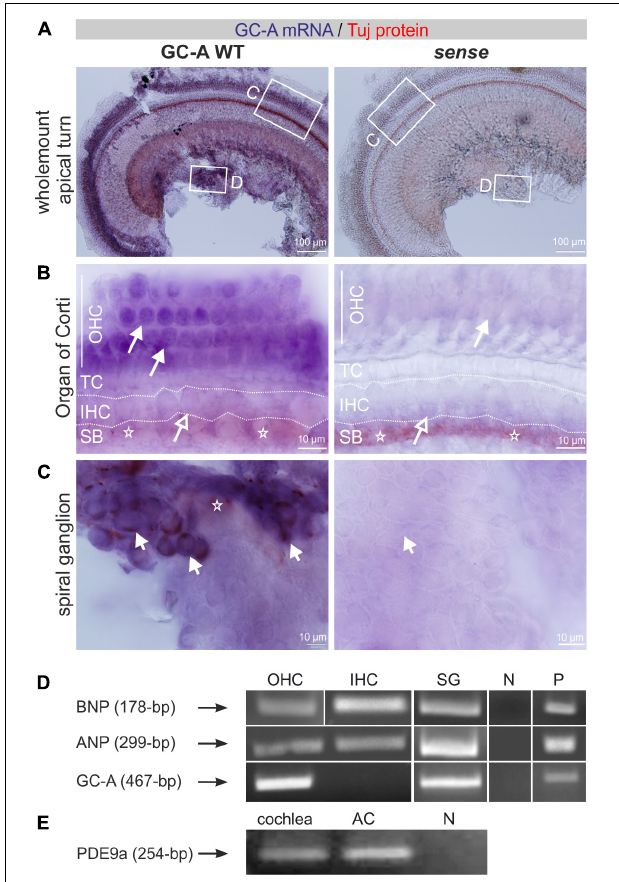
FIGURE 1 | Expression of GC-A, its ligands, and PDE9a in the cochlea. (A) GC-A mRNA and Tuj-1 protein staining in GC-A WT antisense and sense whole-mount cochlear preparations. Scale bars: 100 µ m. (B) GC-A mRNA staining was shown in GC-A WT OHC (closed arrows), but not IHC (open arrows). Tuj-1 staining (stars) in the spiral bundle (SB) in both WT and KO. TC = tunnel of Corti. Scale bars: 10 µ m. (C) GC-A mRNA staining was shown in GC-A WT SGN (short arrows) but not in GC-A KO. Tuj-1 staining (stars) in the SGN. Scale bars: 10 µ m. (D) Reverse transcription-PCR of WT IHC and OHC cDNA shows a fragment of ANP (299-bp) and BNP (178-bp) expressed in isolated OHCs, IHCs, and SG. GC-A at 467-bp was only found in OHCs, but not IHCs. (E) PDE9a was expressed in both cochlear and auditory-cortex (AC) tissue samples. Abbreviations: N, negative control; P, positive control